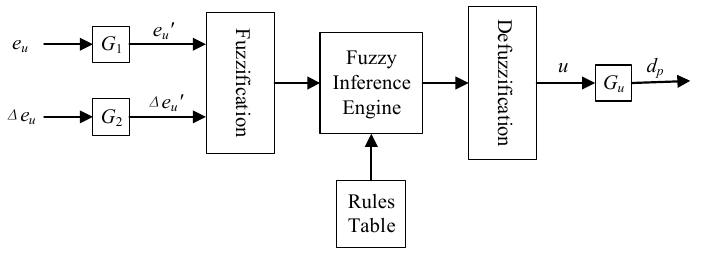
Figure 9. Block diagram of the fuzzy controller for DC-DC converter.